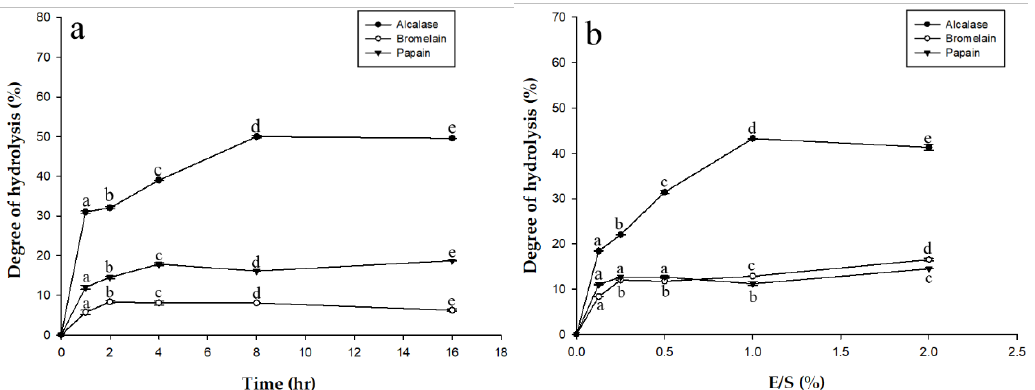
Figure 1. ( a ) Degree of hydrolysis of eel ( Anguilla marmorata ) at di ff erent times with three di ff erent commercial proteases (alcalase, bromelain, and papain) at optimal pH and temperature; ( b ) Degree of hydrolysis of eel ( Anguilla marmorata ) with di ff erent amounts of commercial proteases (alcalase, bromelain, and papain) at optimal pH and temperature. Means in the same form with various characters have significant di ff erences ( p < 0.05). Data are expressed as mean ± SD, from experiments performed in triplicate.